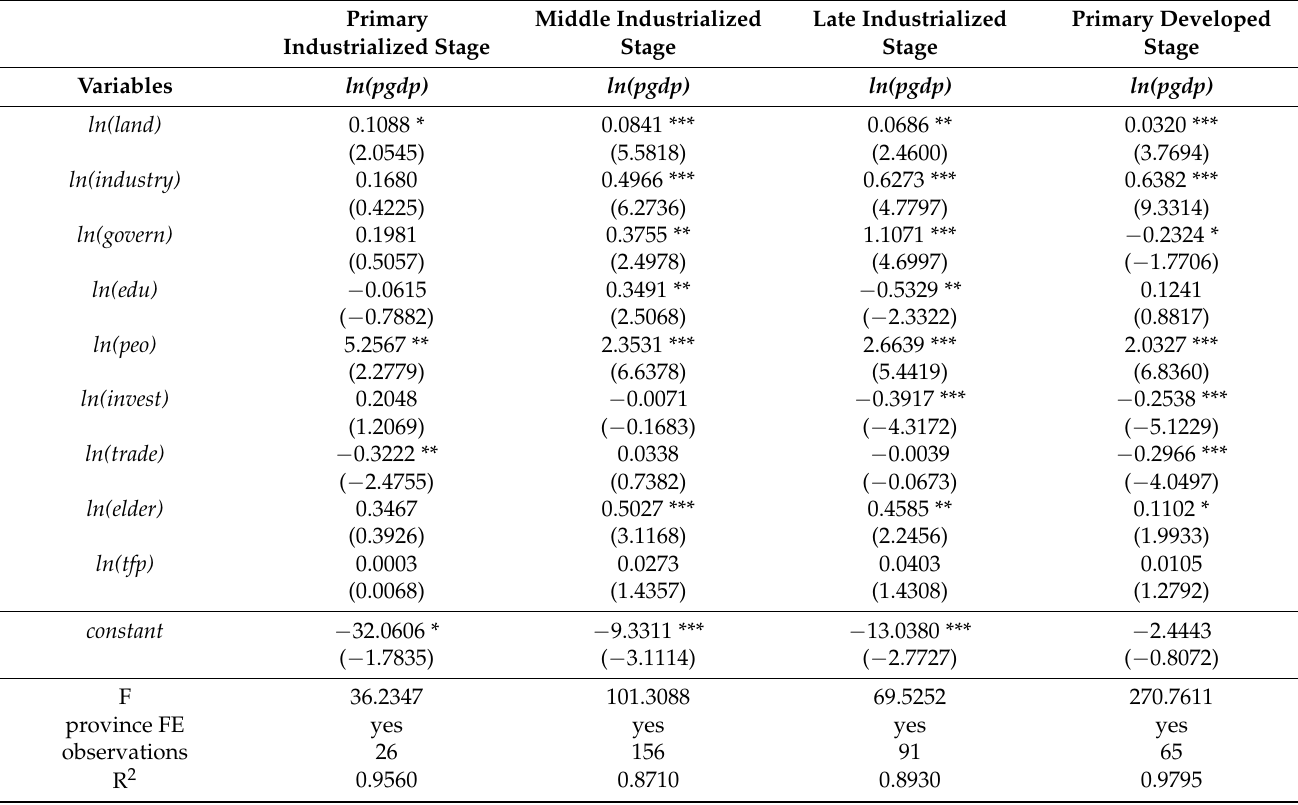
Table 8. Phase-based heterogeneity of transportation land transfer to economic